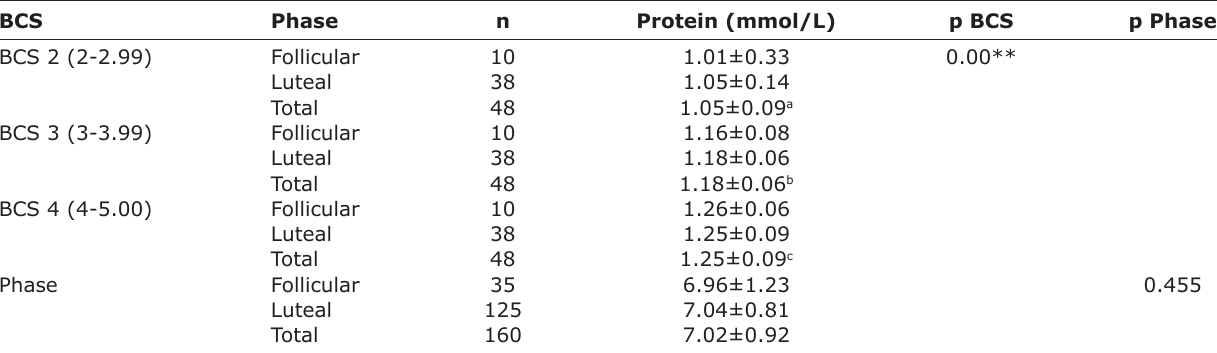
Table-1: Protein levels of Saanen goats in each body condition score during the phases of estrous cycle (mean±SD). BCS